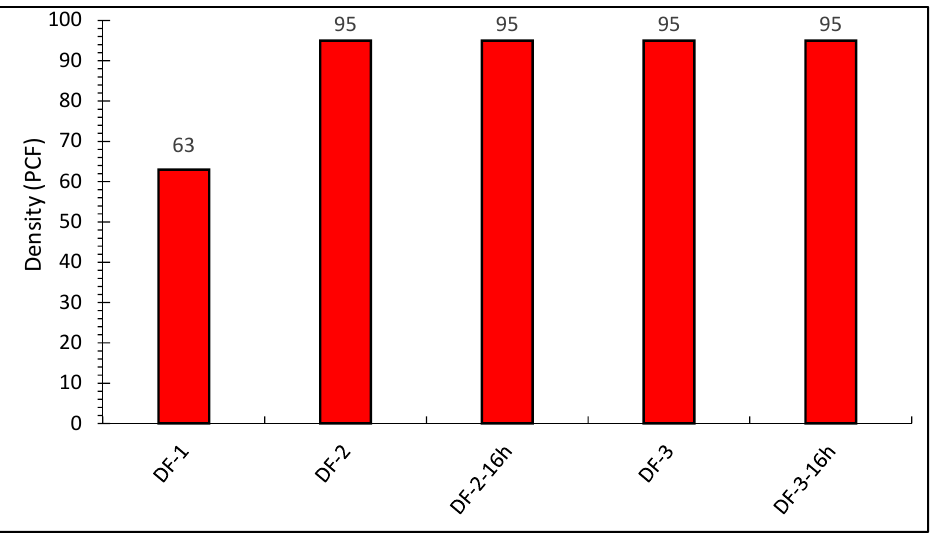
Figure 1. The density of OBDF drilling fluids .